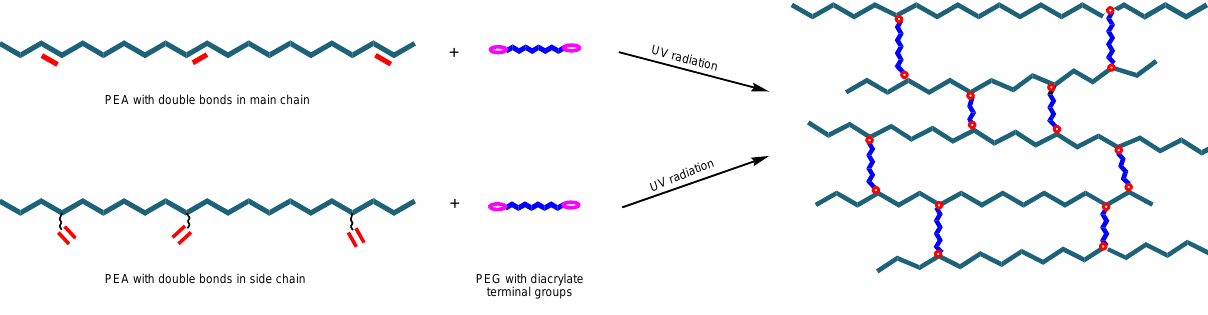
Figure 24. Preparation of hydrogels by photocrosslinking reactions involving carbon-carbon double bonds in the main (a) and side chain (b) .